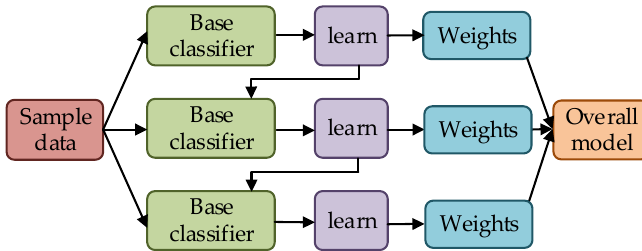
Figure 4. Training process of the gradient-boosting decision tree algorithm.